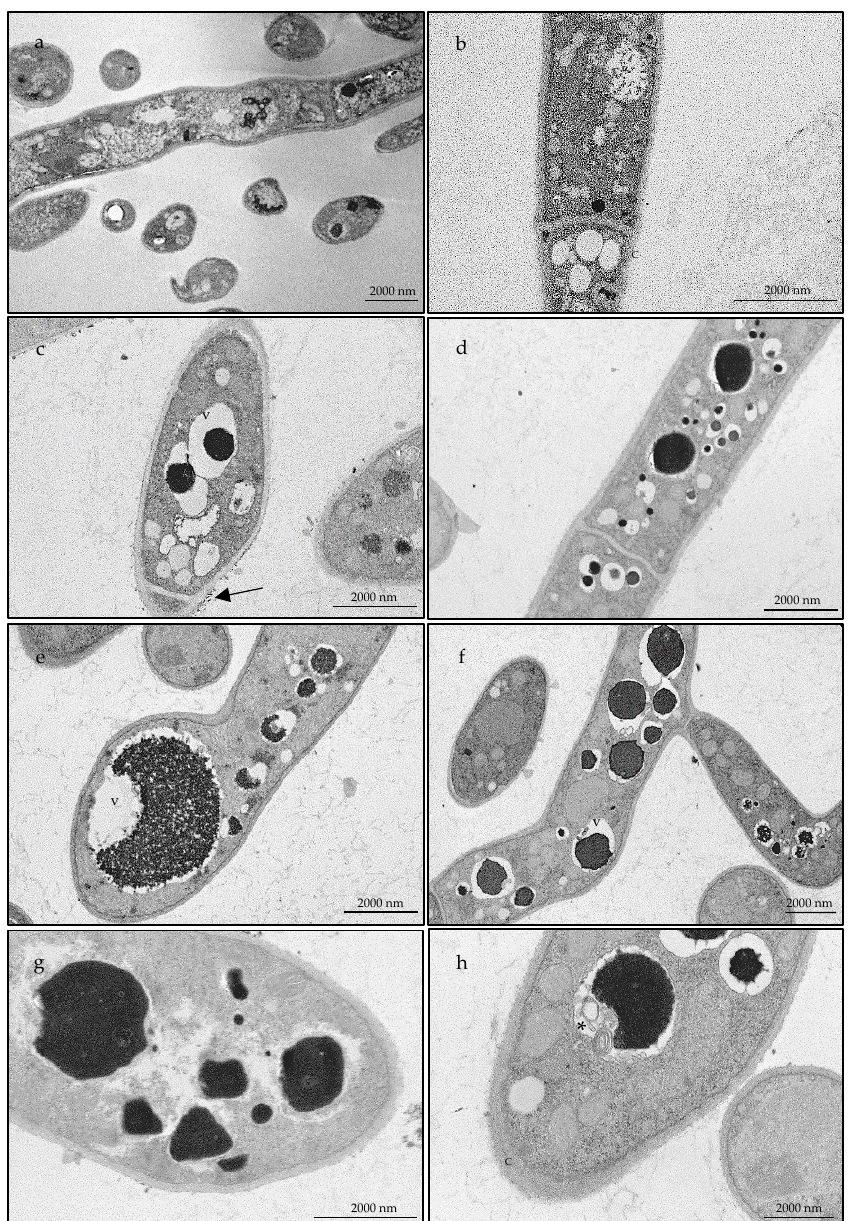
Figure 4. Transmission electron microscopic observations of Trichophyton rubrum in the presence of DMSO ( a , b ) or treated with of 576 µ g/mL of Bupleurum rigidum subsp. paniculatum essential oil ( c – h ). Arrow points to fragments from the cell wall; * shows an autophagic structure; c—cell wall,